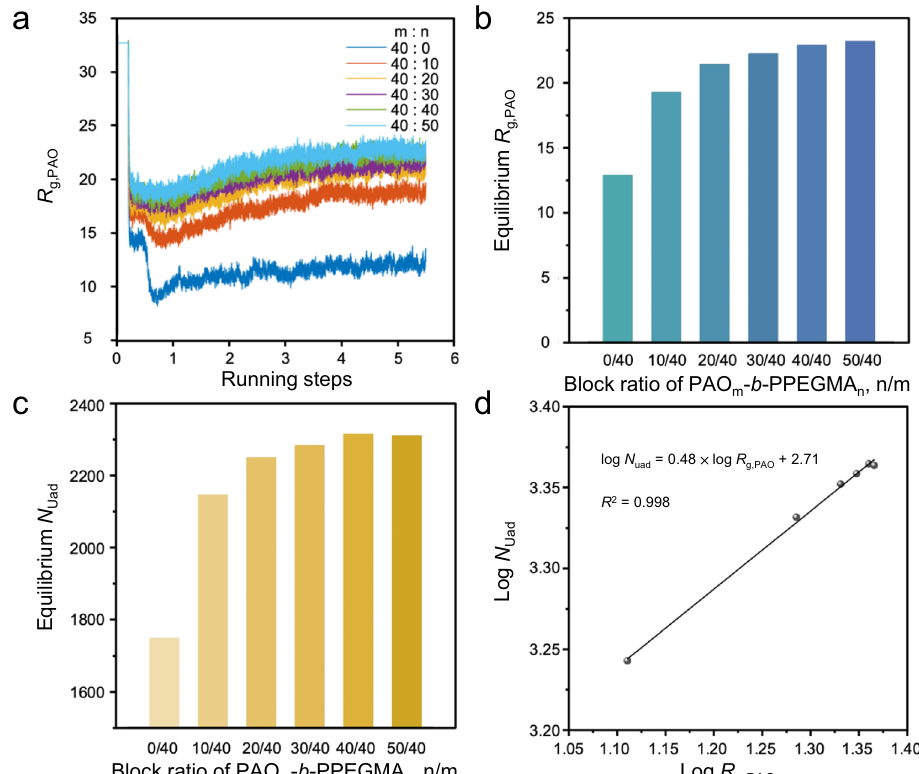
Fig. 4 Computational simulation outcomes and data processing. a Variation of R g,PAO with running steps for PAO m - b -PPEGMA n with different block ratios. b The equilibrium R g,PAO of PAO m - b -PPEGMA n with different block ratios. c The number of adsorbed U-beads ( N Uad ) b y PAO m - b -PPEGMA n with different block ratios. d The linear fi tting curve of log N Uad to log R g,PAO